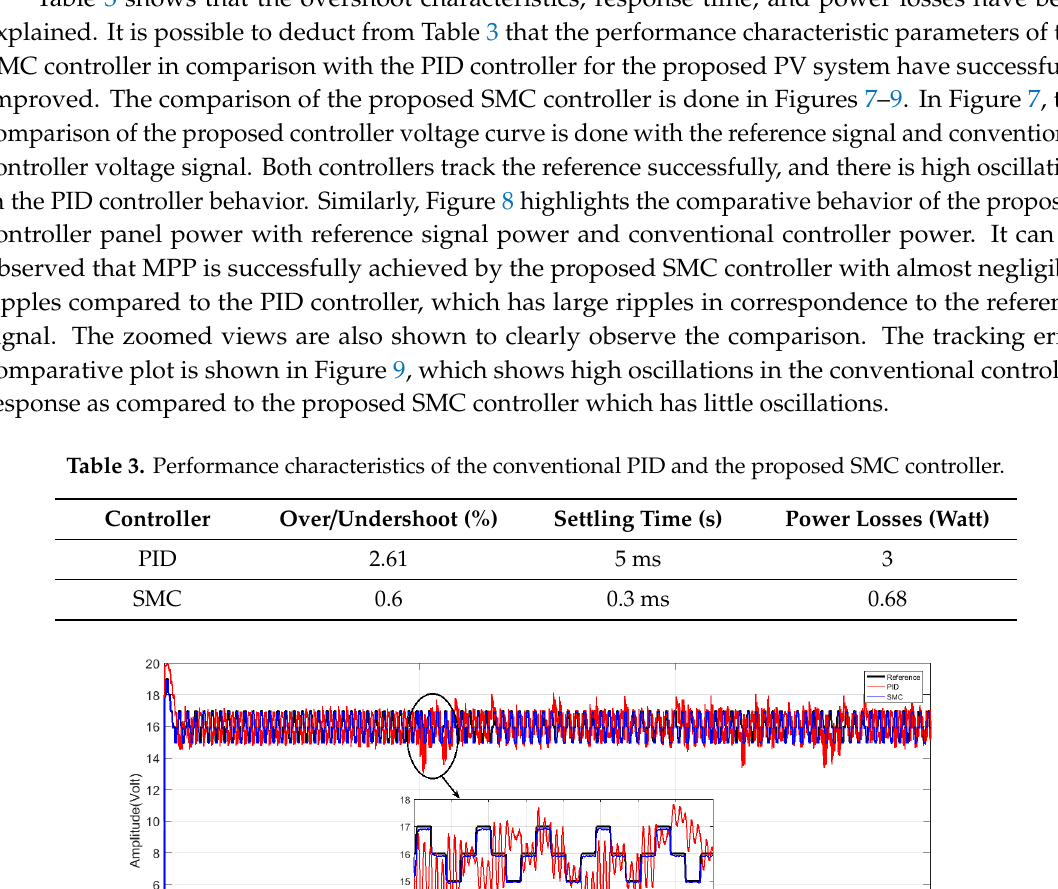
Figure 6. ( a ) Profile of the PV panel voltage, ( b ) tracking response of the proposed SMC controller, and ( c ) profile of power extraction.